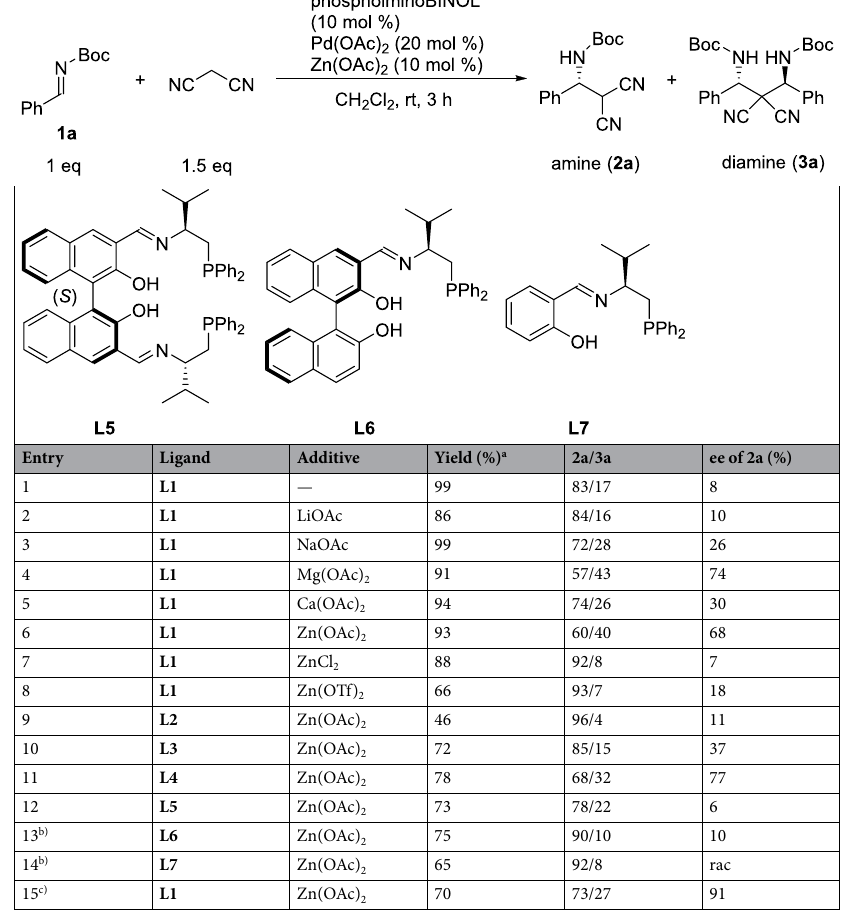
Table 1. Development of dinuclear phosphoiminoBINOL-metal catalyst for Mannich reaction using malononitrile. a) Conversion yield (see details for the determination in SI). b) 10 mol % of Pd(OAc) 2 were